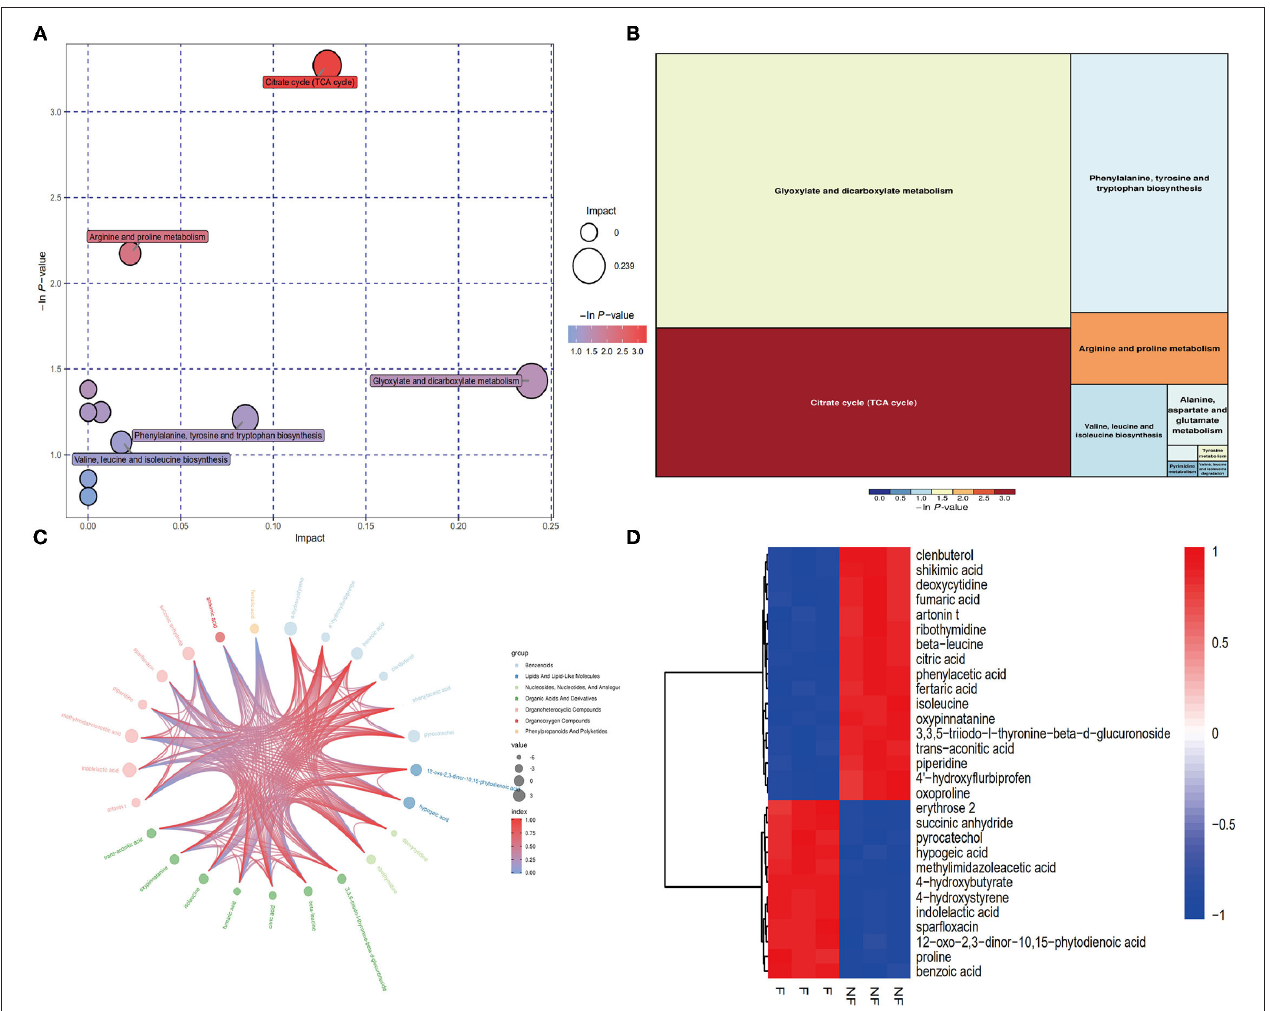
FIGURE 4 | Improvement of different metabolites of PNL and FPNL. (A) Bubble plot displays the increasing impact of the enrichment analysis of metabolic pathways, with key bubbles reflecting that the metabolic pathways were significantly altered by fermentation. (B) Heatmap clearly shows the relationship in potential biomarkers after fermentation. (C) Chord diagram of metabolic differences. (D) Metabolites differential enrichment